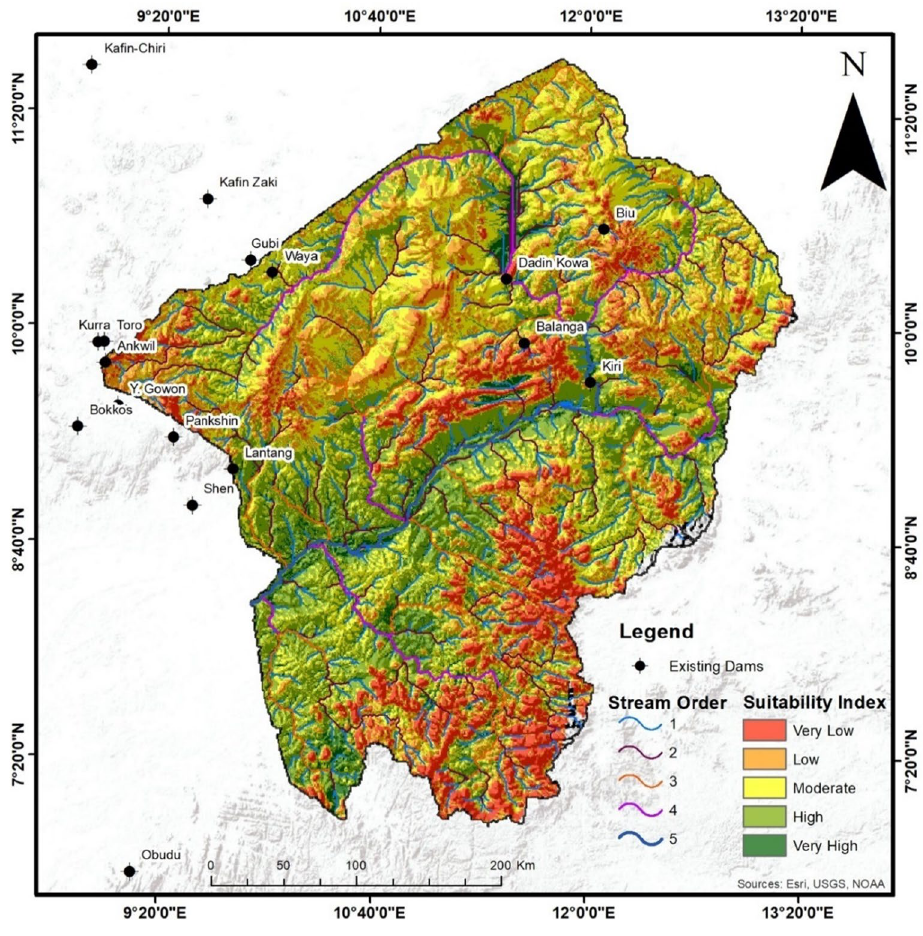
Fig. 7 Distribution of existing dams on the suitability